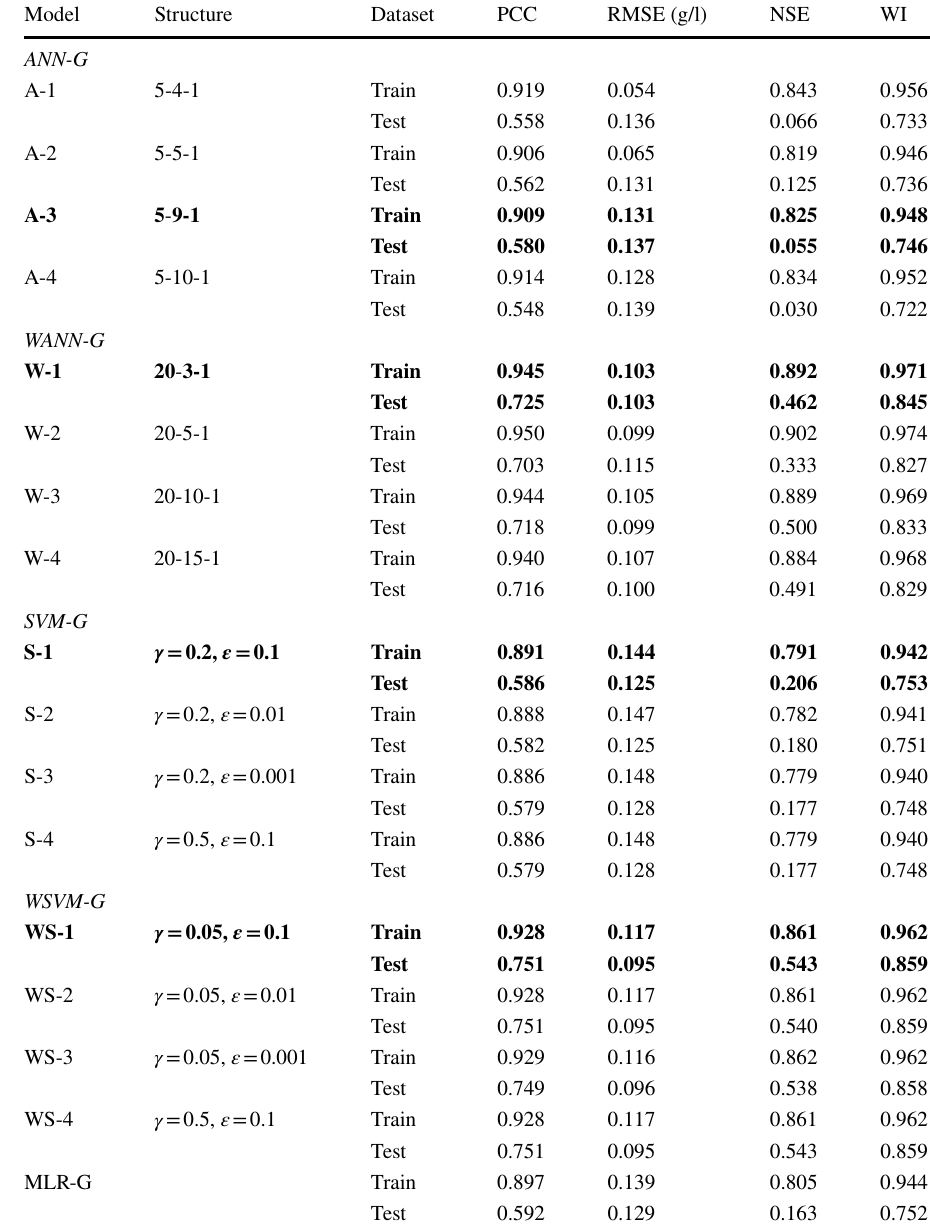
modelsModel Structure